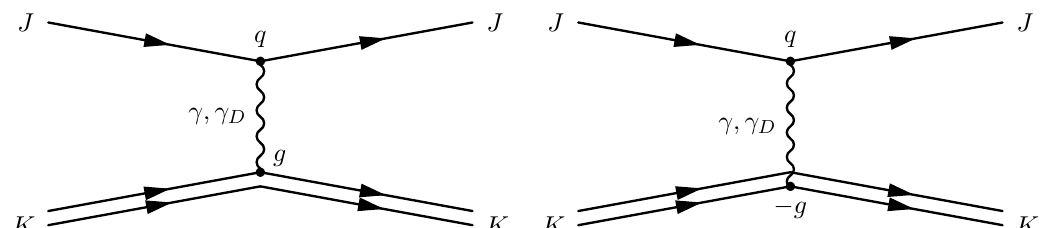
Figure 4 . The t -channel scattering of an electrically charged particle and a bound magnetic monopole and anti-monopole. There are two diagrams with the exchange of the visible photon and two with the exchange of the dark